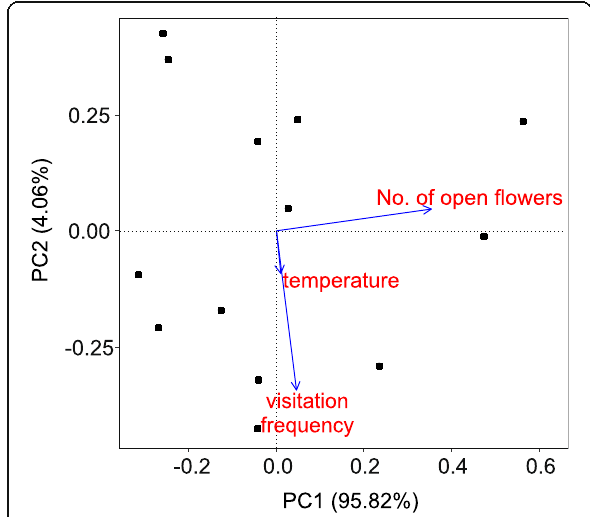
Fig. 4 Principal Component Analysis (PCA) of the relationship between environmental temperature, number of open avocado flowers and bee visitation frequency, Hijuelas orchard, Valparaíso Region,